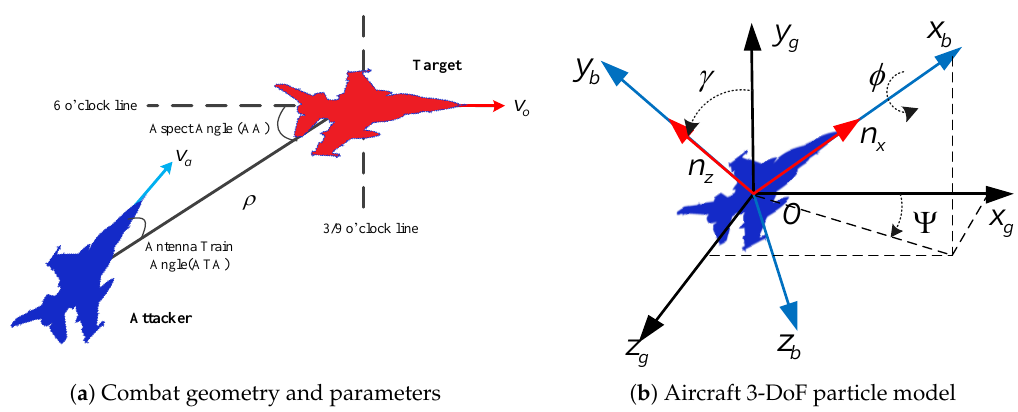
Figure 2. The geometric situation of the aerial